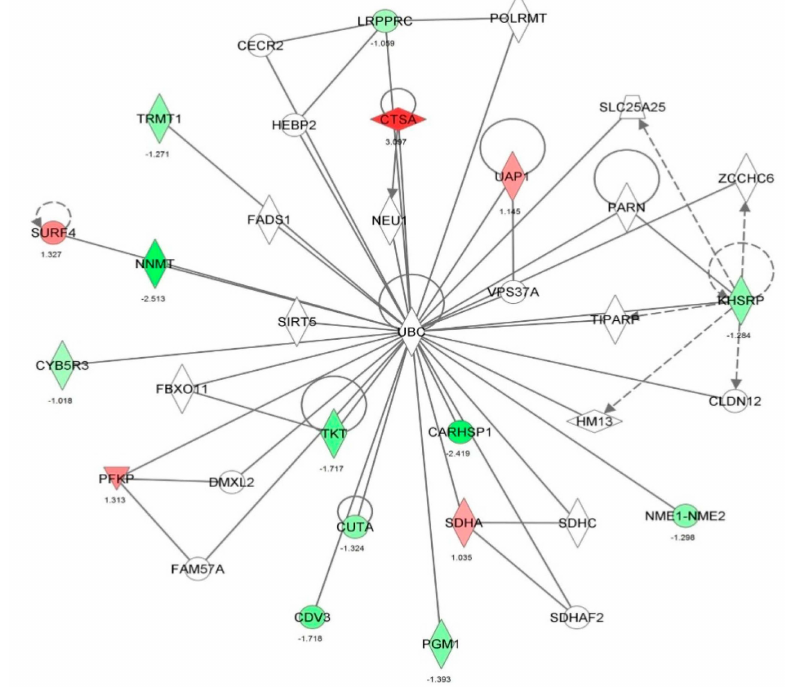
Figure 21. Vancomycin regulated developmental disorder, hereditary disorder, and metabolic disease. Red indicates an up-regulation; green indicates a down-regulation. The intensity of green and red colors indicates the degree of down- or up-regulation. Solid arrow indicates direct interaction and dashed arrow indicates indirect